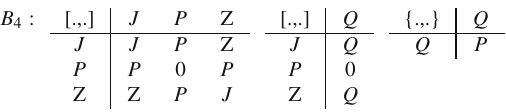
ator content 1 × J